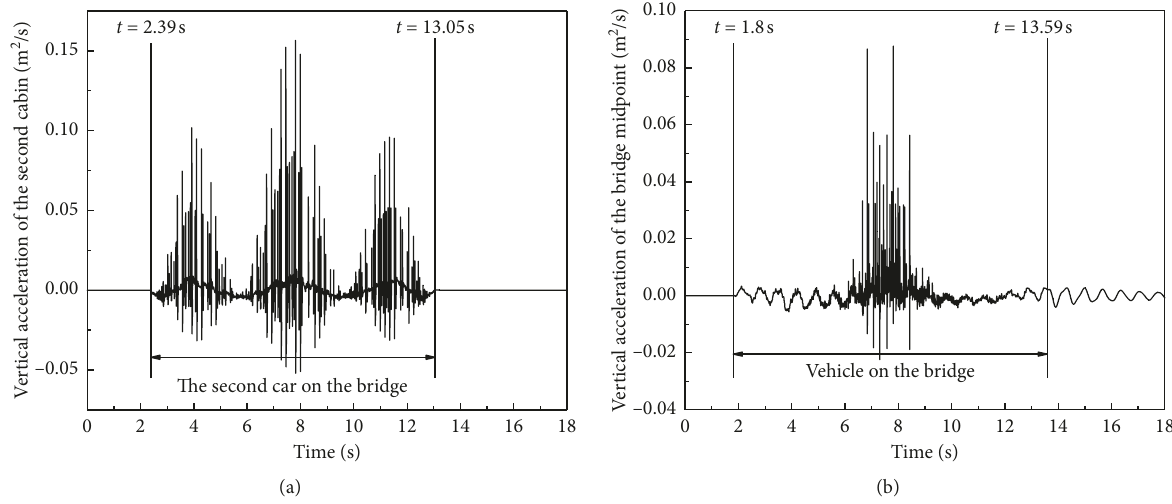
Figure 6: Mean values of vertical accelerations for (a) the second cabin and (b) the bridge